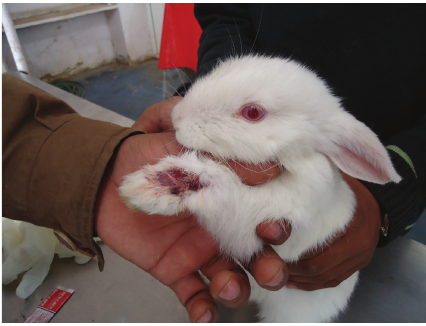
History revealed normal feeding, defecation, urination, and separation of rabbit from his mother as she was suffering from mange. Clinical examination showed a single well demarcated, oval, alopecic, ulcerated lesion with peripheral hyperpigmentation and thickening at the carpus of left forelimb (Figure 1). Surface exudate was absent probably due to continuous licking of lesion. All the vital